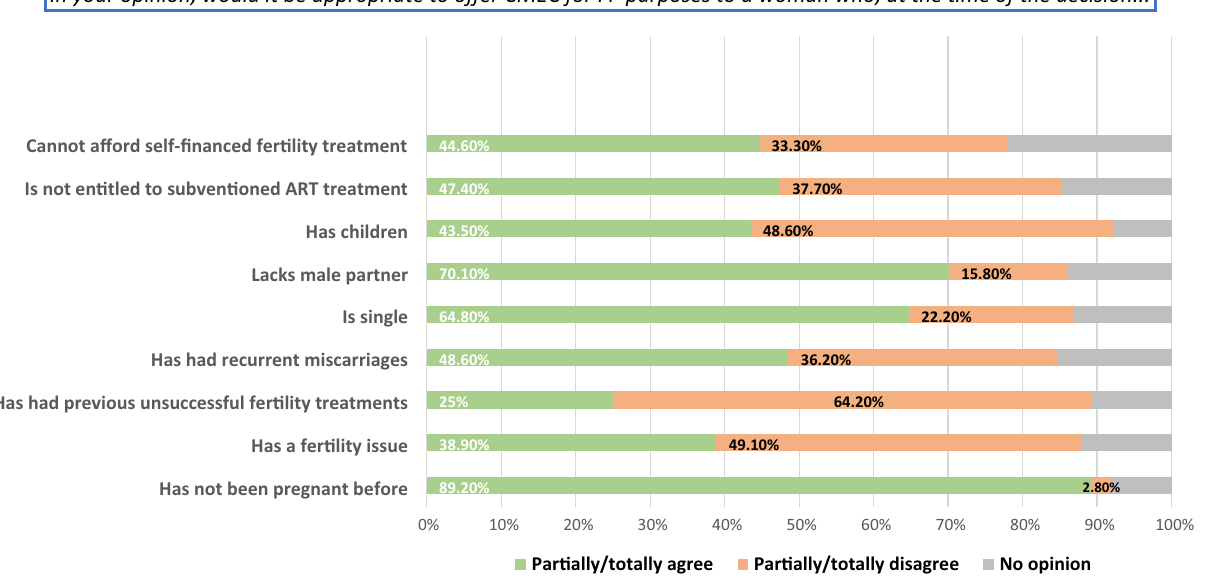
Figure 2. Opinions on fertility-related eligibility criteria for conservative treatment of endometrial cancer. CMEC Conservative management of endometrial cancer, FP fertility preservation, ART assisted reproductive